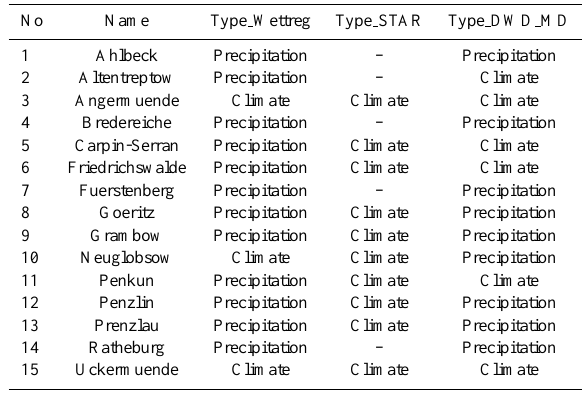
Table 1. Types of weather stations in the Ucker